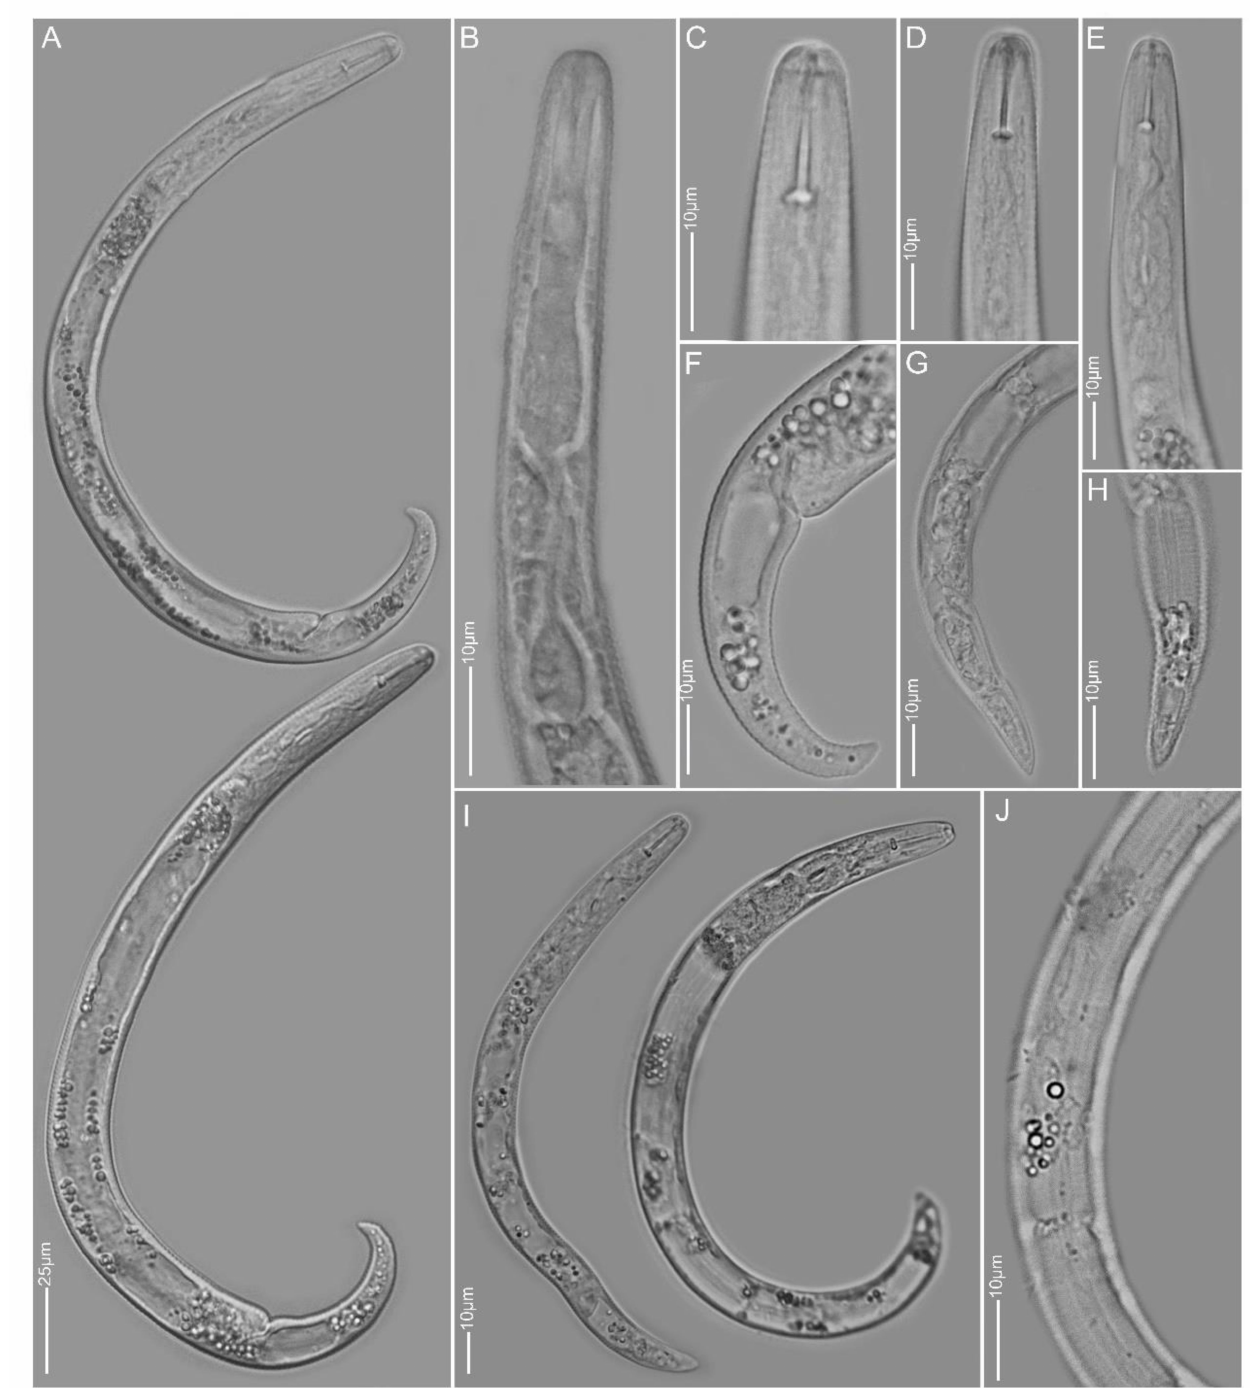
Figure 13. Light microscopy images of Paratylenchus sp.BE11 females: ( A ) total body; ( B – E ) anterior region; ( F – H ) tail region; ( I ) total body; ( J ) lateral